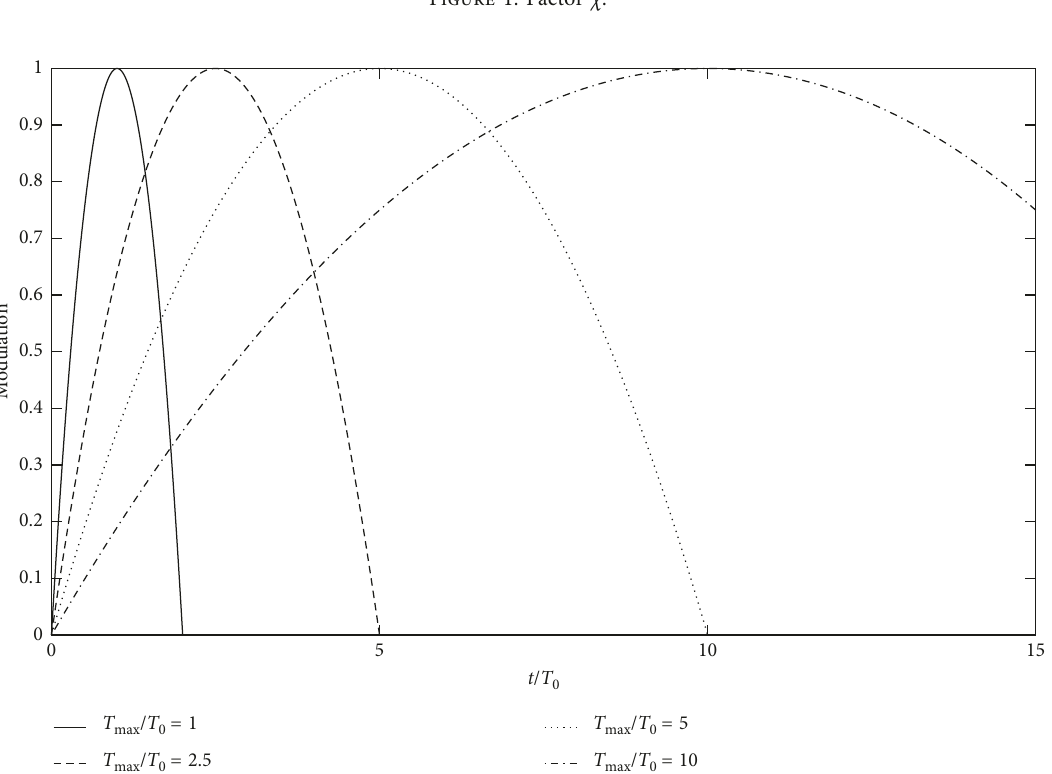
Figure 2: Parabolic modulation function for different values of t